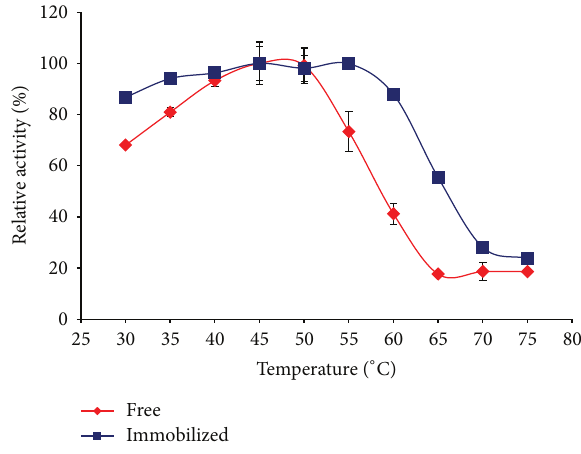
Figure 4: Optimum temperature for free and covalently immobi- lized 𝛽 -galactosidase onto gel beads treated with polyethylenimine (PEI), followed by glutaraldehyde.